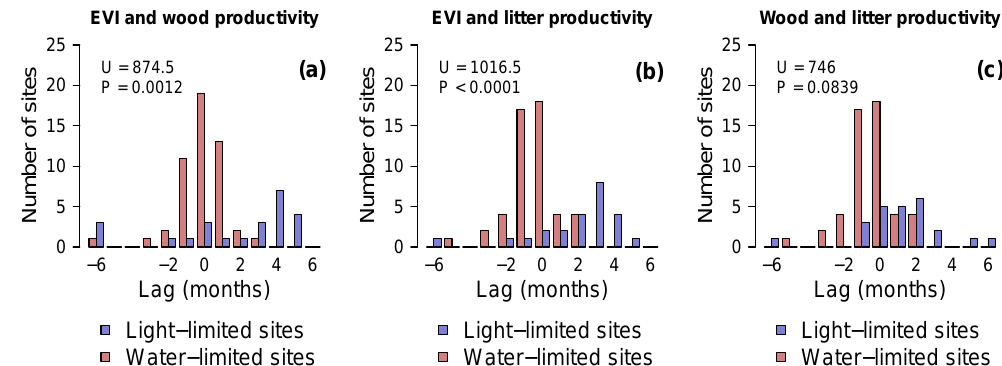
Figure 10. Cross-correlation between monthly EVI and wood productivity (a) , EVI and litter productivity (b) and wood and litter productivity (c) for water- and light-limited sites. The x axis indicates the time-lag to get the maximum correlation between the variables. When no observations were available for wood and litter productivity, predictions from the climatic model were used (Table 4). To facilitate graphical representation, cross-correlation (a) is positive, while (b) and (c) are negative. A positive cross-correlation at lag of 1month indicates a similar seasonal pattern in the time series with a time lag of 1month, while a negative cross-correlation at lag 1month indicates an opposite seasonal pattern with a time lag of 1month. All the water-limited and light-limited sites were represented (respectively 50 and 24 sites) as only 4 water-limited sites in (a) and 3 in (b) , and only 2 light-limited sites in (c) have no statistically significant